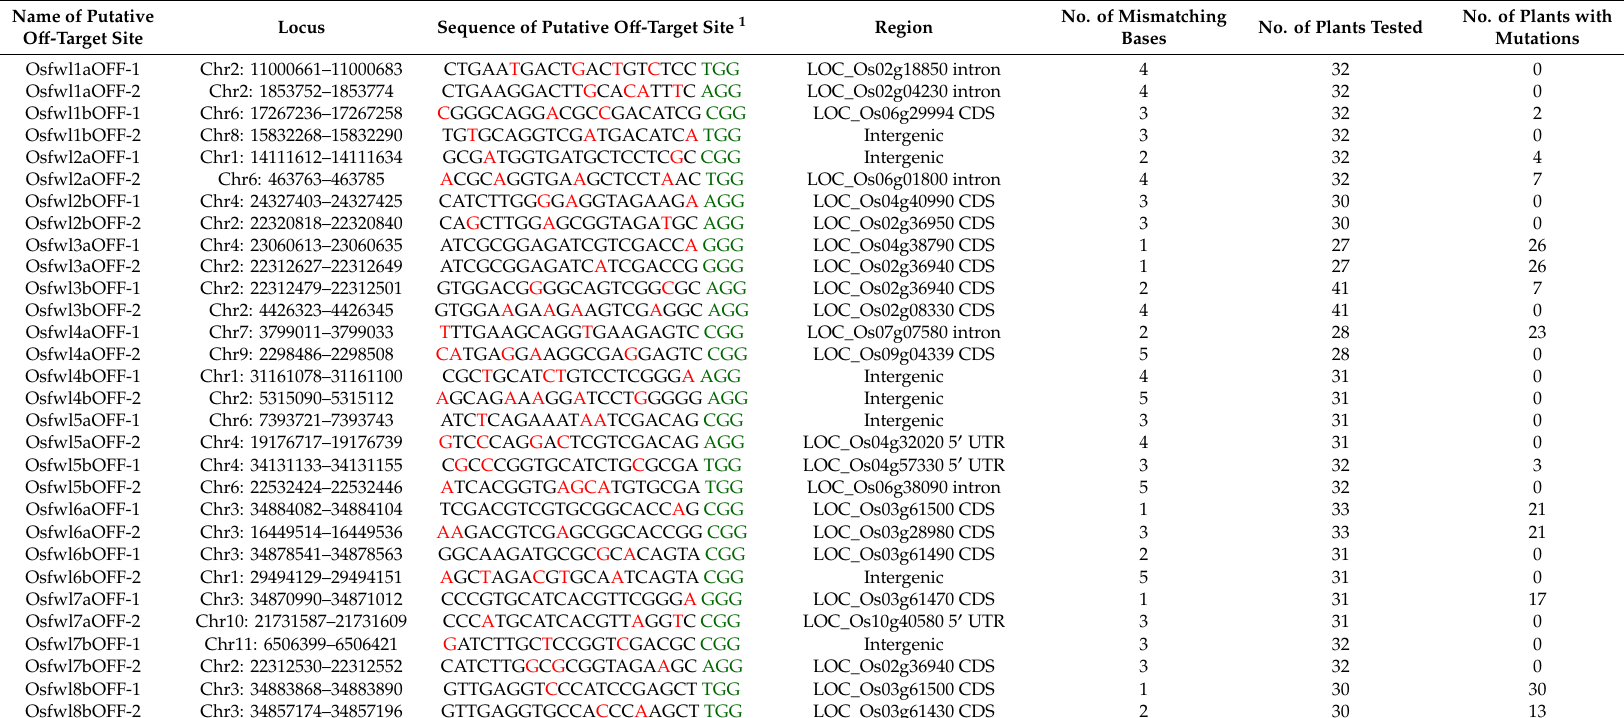
Table 3. O ff -target e ff ect analysis of transgenic